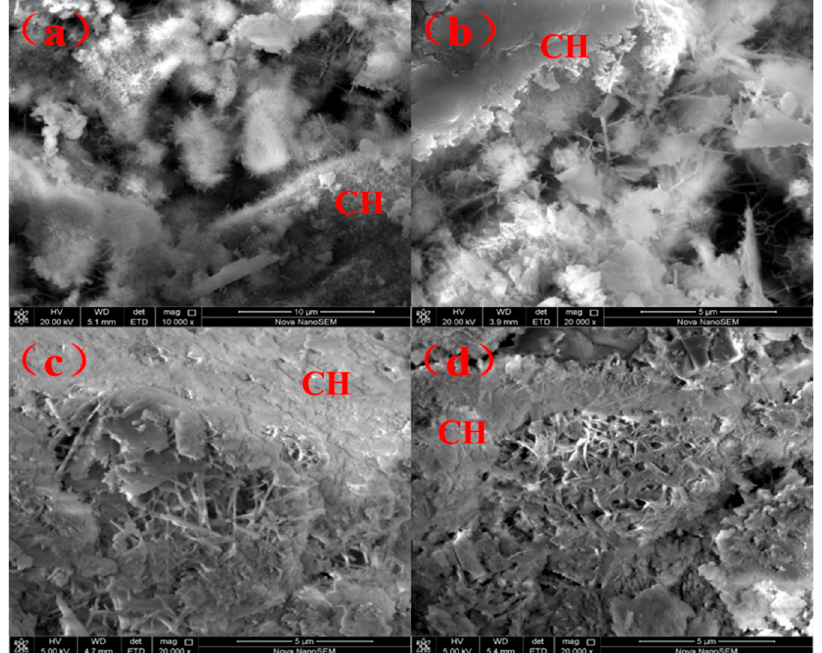
Figure 5. SEM images of T3-2 sample after being cured for 28 days ( a ) and of T4-1 samples for 3, 7, and 28 days of curing ( b , c , d ).